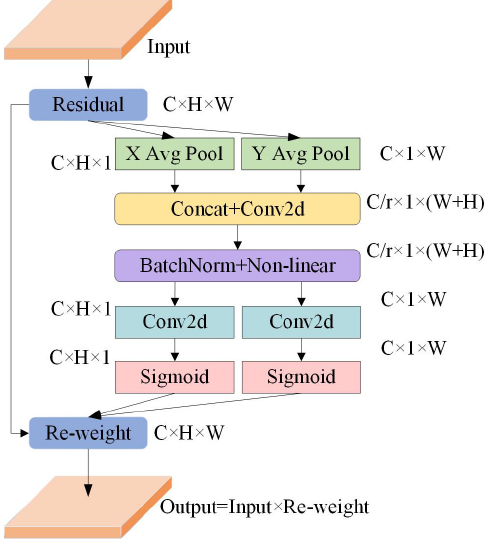
Figure 6. CA module network